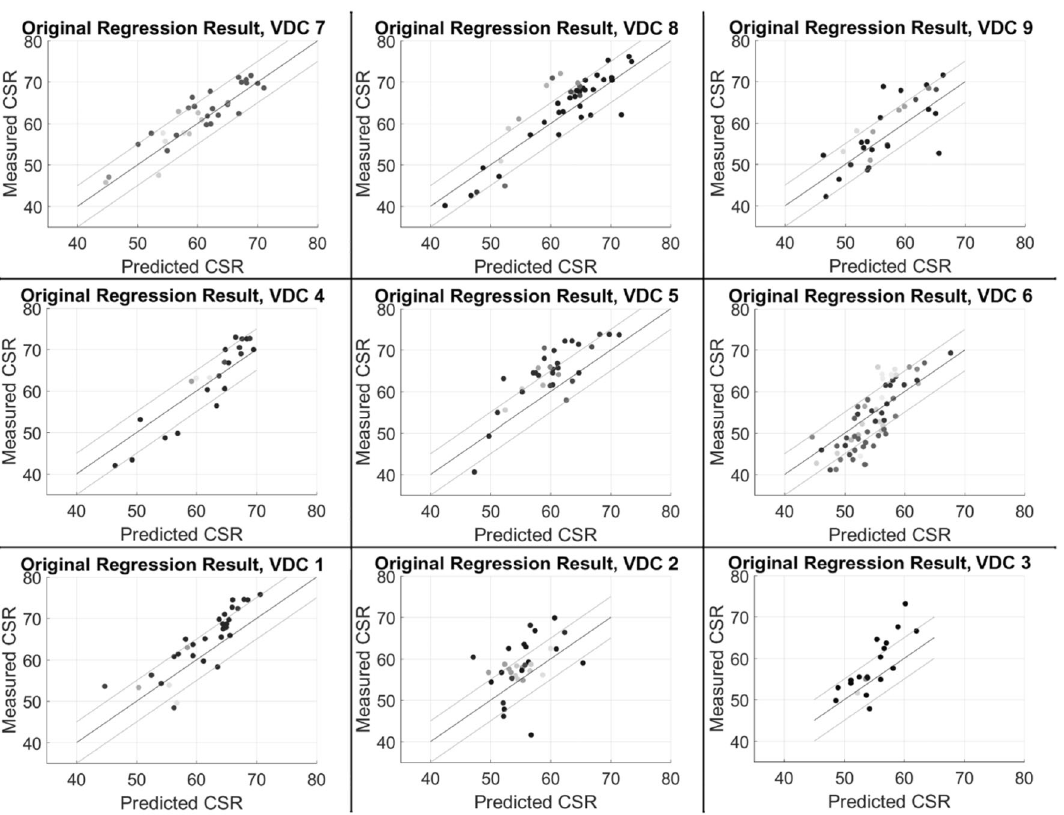
Fig. 5 Original regression fits, grouped by VDCs, and shaded by percentage Australian coals, where the darker the data point, the higher the proportion of Australian coal